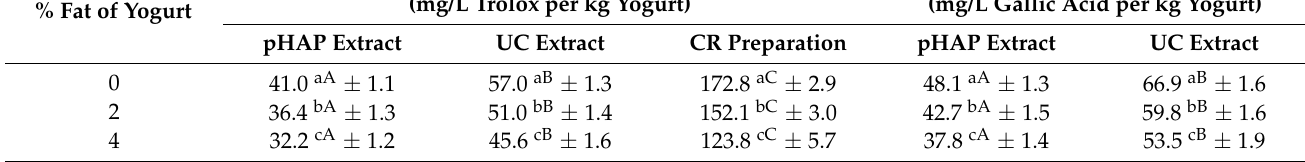
Table 8. Antioxidant activities of cow yogurts with different fat content preparations obtained by pH adjustment and precipitation (pHaP), ultra-centrifugation (UC), and “Clarifying Reagent” (CR), as determined by FRAP assay 1